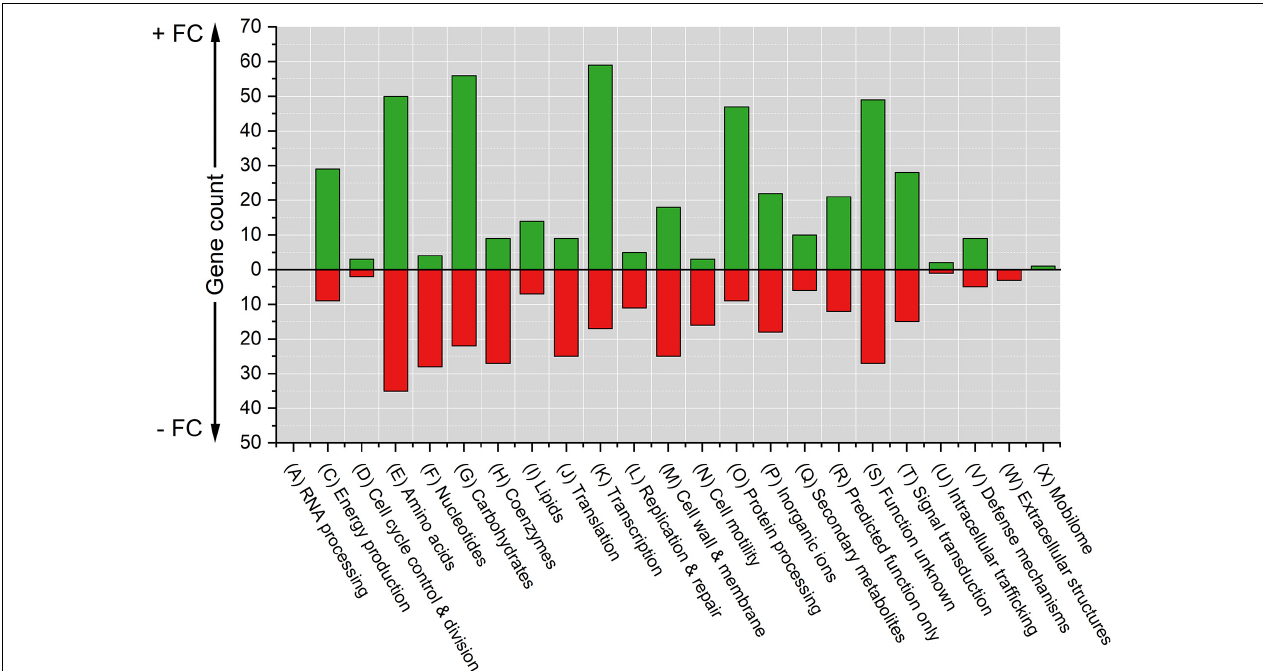
FIGURE 2 | Counts of differentially expressed genes due to Pd stress grouped by COG functional categories. The cut-off p -value was 0.05. Positive counts represent observed up-regulated genes (green bars) and negative counts represent observed down-regulated genes (red bars). COG code, number of proteins encoded by E. coli genome and category description: (A, 3) RNA processing and modification; (C, 284) Energy production and conversion; (D, 43) Cell cycle control, cell division, and chromosome partitioning; (E, 356) Amino acid transport and metabolism; (F, 107) Nucleotide transport and metabolism; (G, 384) Carbohydrate transport and metabolism; (H, 180) Coenzyme transport and metabolism; (I, 122) Lipid transport and metabolism; (J,236) Translation, ribosomal structure and biogenesis; (K, 301) Transcription; (L, 140) Replication, recombination, and repair; (M, 254) Cell wall, membrane, and envelop biogenesis; (N,110) Cell motility; (O, 178) Post-translational modification, protein turnover, and chaperones; (P, 223) Inorganic ion transport and metabolism; (Q, 72) Secondary metabolites biosynthesis, transport, and catabolism; (R, 261) General function prediction only; (S, 255) Function unknown; (T, 193) Signal transduction mechanisms; (U, 50) Intracellular trafficking, secretion, and vesicular transport; (V, 93) Defense mechanisms; (W, 31) Extracellular structures; and (X, 60) Mobilome, prophages, and transposons.